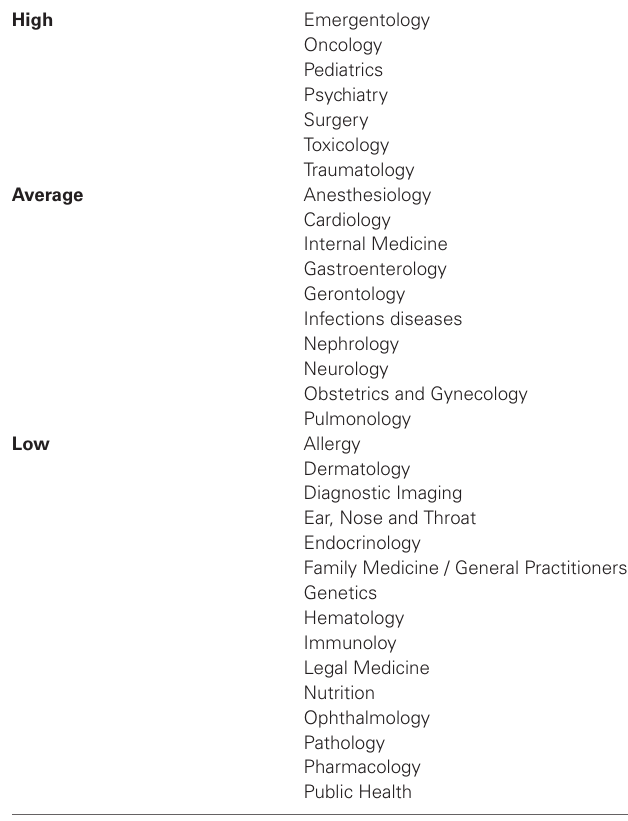
Table 1 | Classification of medical specialties based on the opinion of 137 independent raters (who were medical doctors) assessing whether each field poses settings of high, average, or low emotional exhaustion